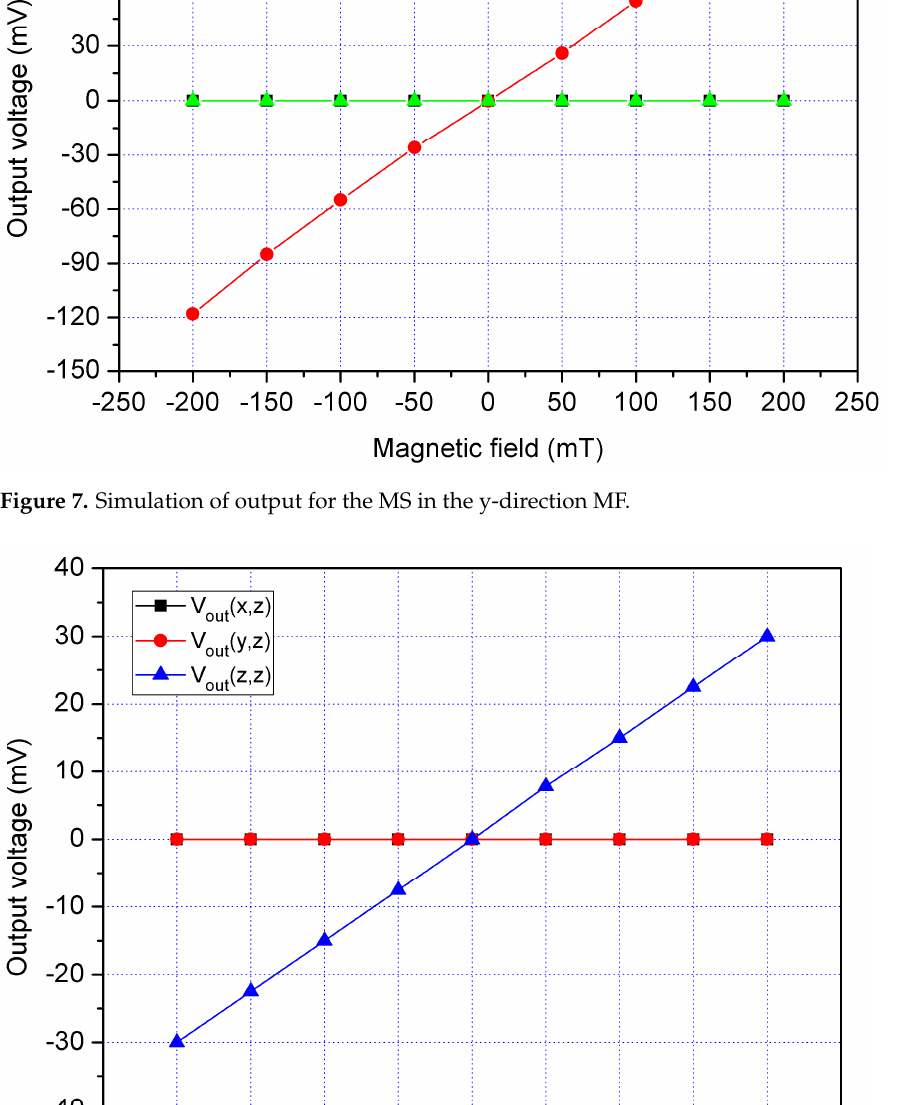
Figure 8. Simulation of output for the MS in the z-direction MF.